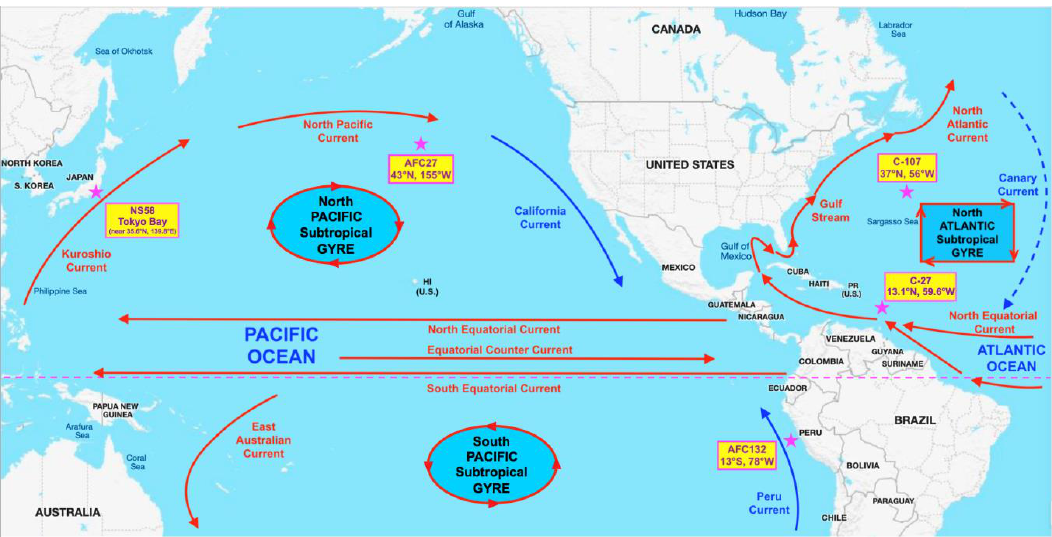
Figure 1. Locations of isolation of the studied Nitrosococcus oceani strains in the Pacific and Atlantic Oceans. Strains labeled with a “C - ” were originally collected, enriched , and maintained by Stanley W. Watson (Woods Hole Oceanographic Institute, Woods Hole, MA, USA); strains label ed with a “AFC” were originally collected, enriched, and maintained by Angelo F. Carlucci (Scripps Institution, San Diego, CA, USA).